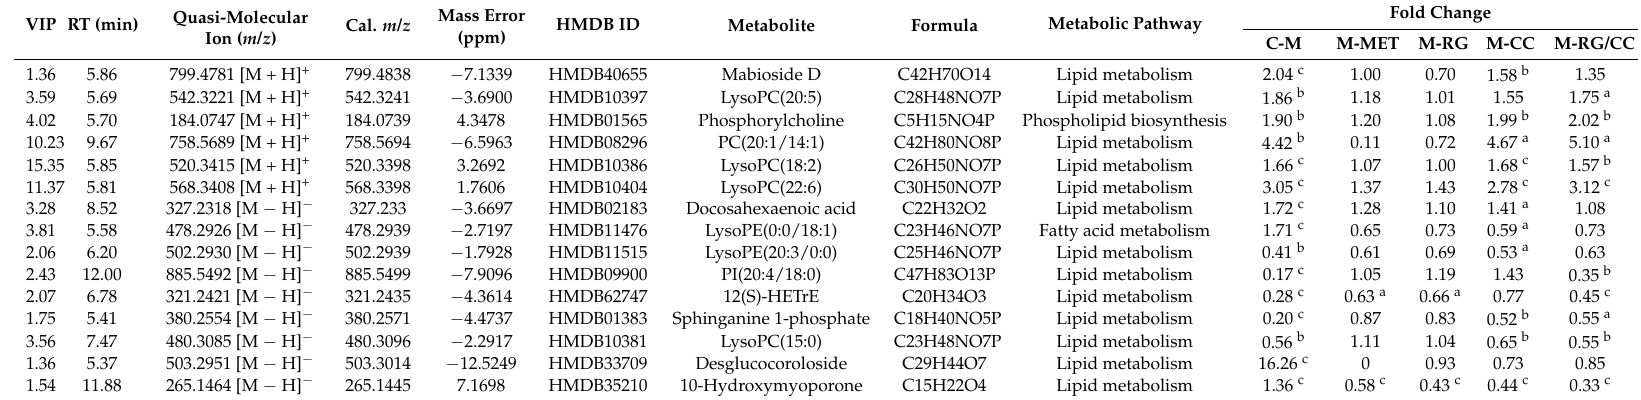
Table 2. Annotation of HFD-induced serum biomarkers in diabetic mice and their alteration by four